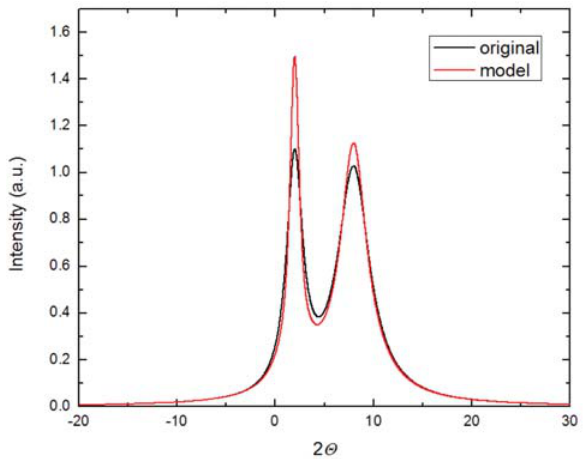
Figure 6. Original profile labeled in black, and enhanced profile (obtained by the summation of the original profile and the negative scaled 2 nd derivative) labeled in red.